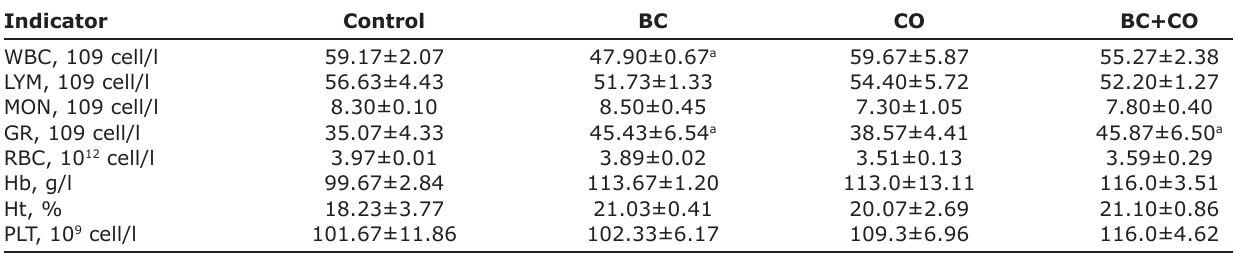
Table-3: Morphological blood parameters with Bacillus cereus and coumarin in diets (day 42).